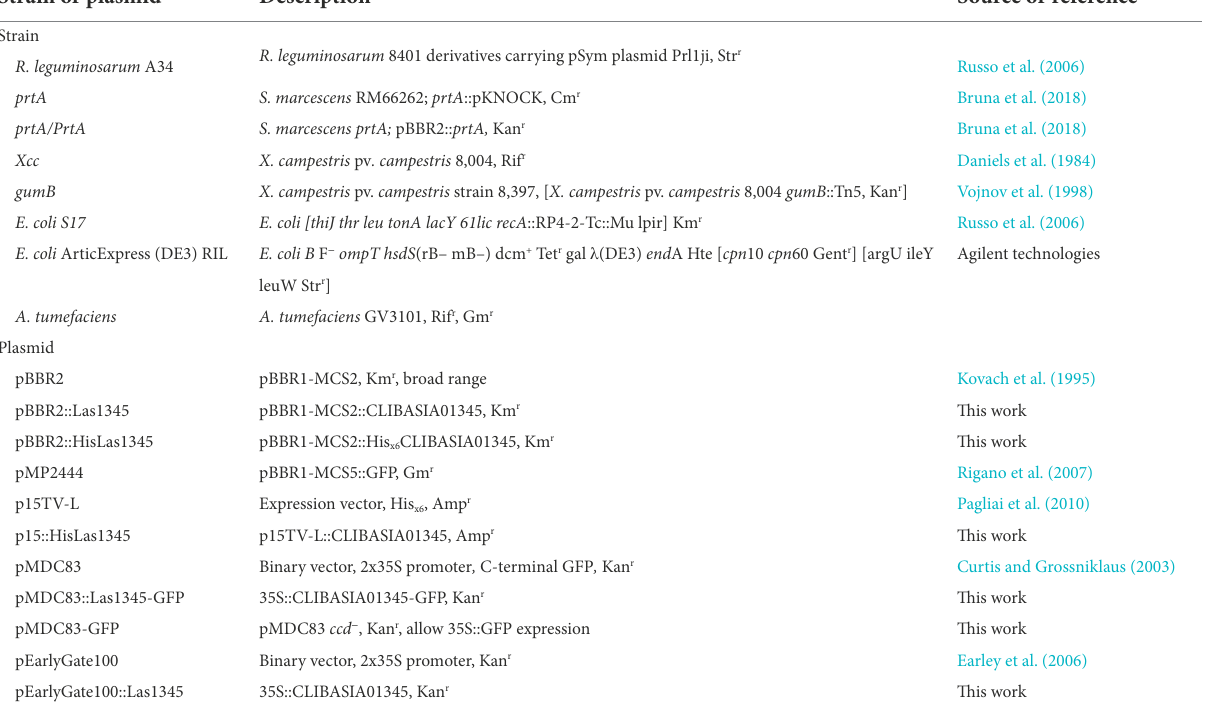
TABLE 1 Bacterial strains and